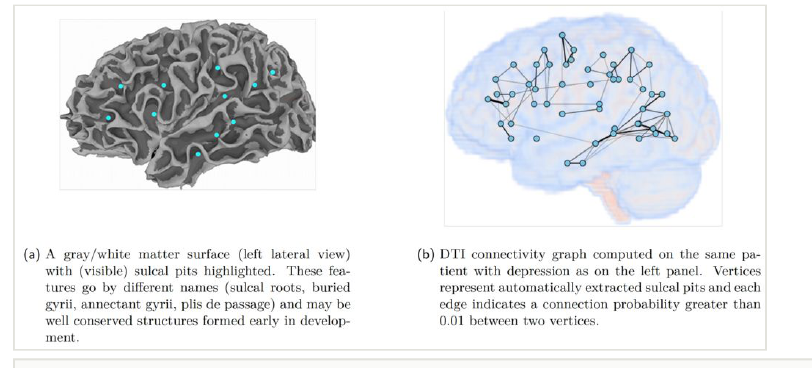
Figure 3. Example of a graph-based representation of MRI and DTI features (a) A gray/white matter surface (left lateral view) with (visible) sulcal pits highlighted. These features go by di ff erent names (sulcal roots, buried gyrii, annectant gyrii, plis de passage) and may be well conserved structures formed early in development. (b) DTI connectivity graph computed on the same patient with depression as on the left panel. Vertices represent automatically extracted sulcal pits and each edge indicates a connection probability greater than 0.01 between two